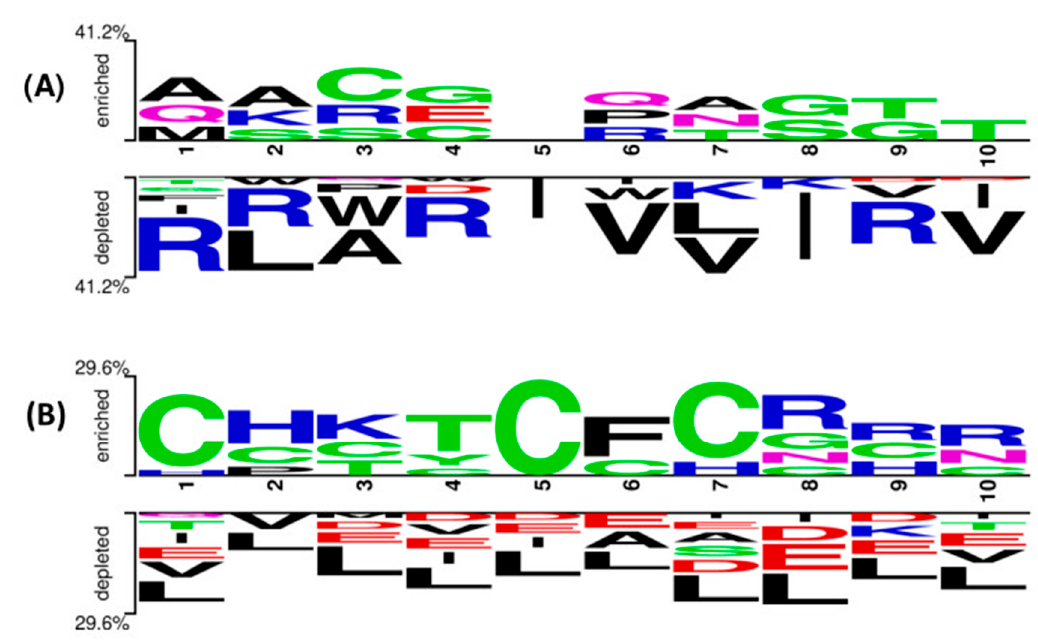
Figure 4. Two sample logos illustrate the position preference of the first 10 residues present in PhytoAFP and Non-PhytoAFP at ( A ) N-terminus and ( B ) C-terminus, respectively .